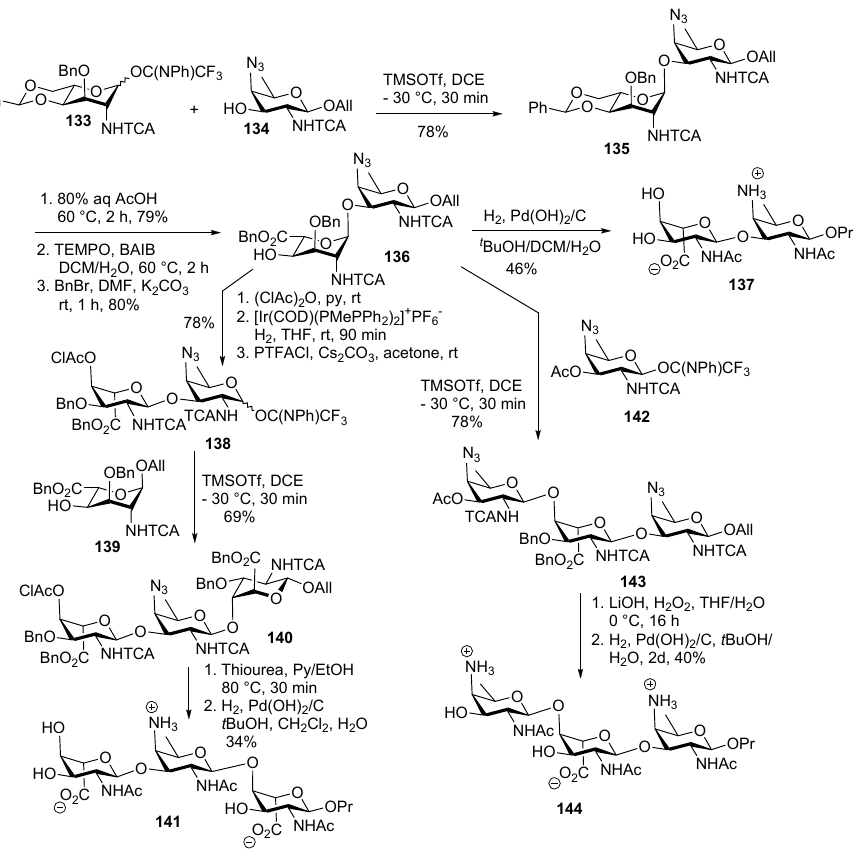
Scheme 15. Mulard’s total synthesis of ZPS of Shigella sonnei.